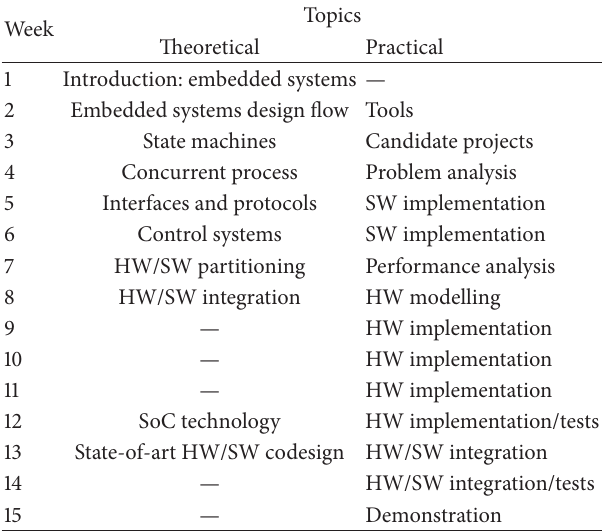
Table 1: SSC0711: course